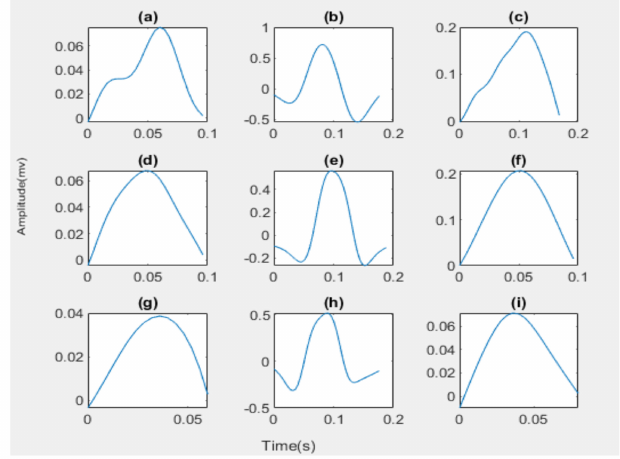
Figure 5. The wave segmentation for ECG types: ( a ) The Normal P-wave; ( b ) The Normal QRS- waves; ( c ) The Normal T-wave; ( d ) The Bradycardia P-wave; ( e ) The Bradycardia QRS-waves; ( f ) The Bradycardia T-wave; ( g ) The Tachycardia P-wave; ( h ) The Tachycardia QRS-waves; ( i ) The Tachycardia